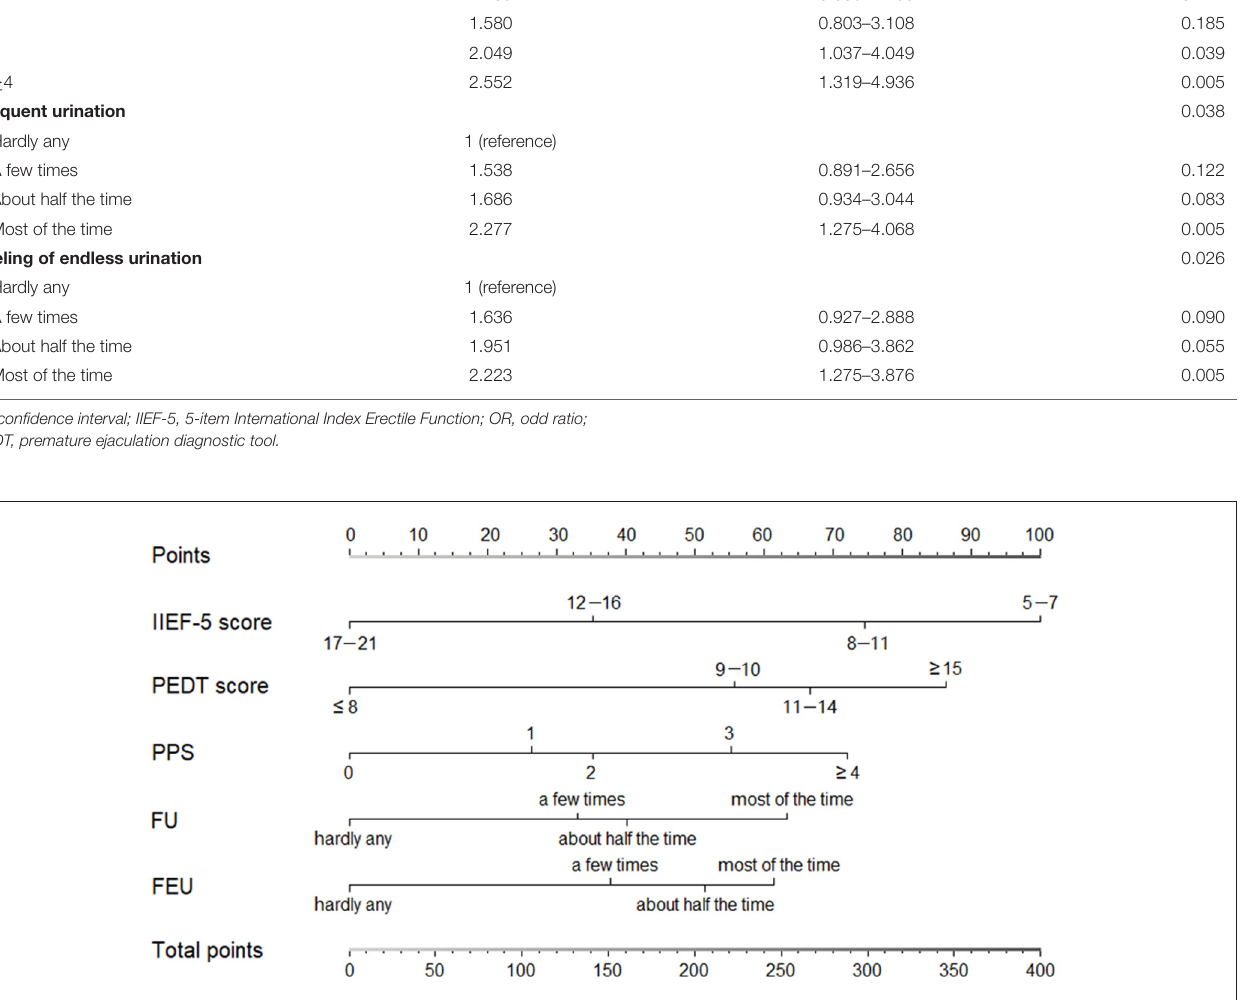
Frontiers in Public Health |